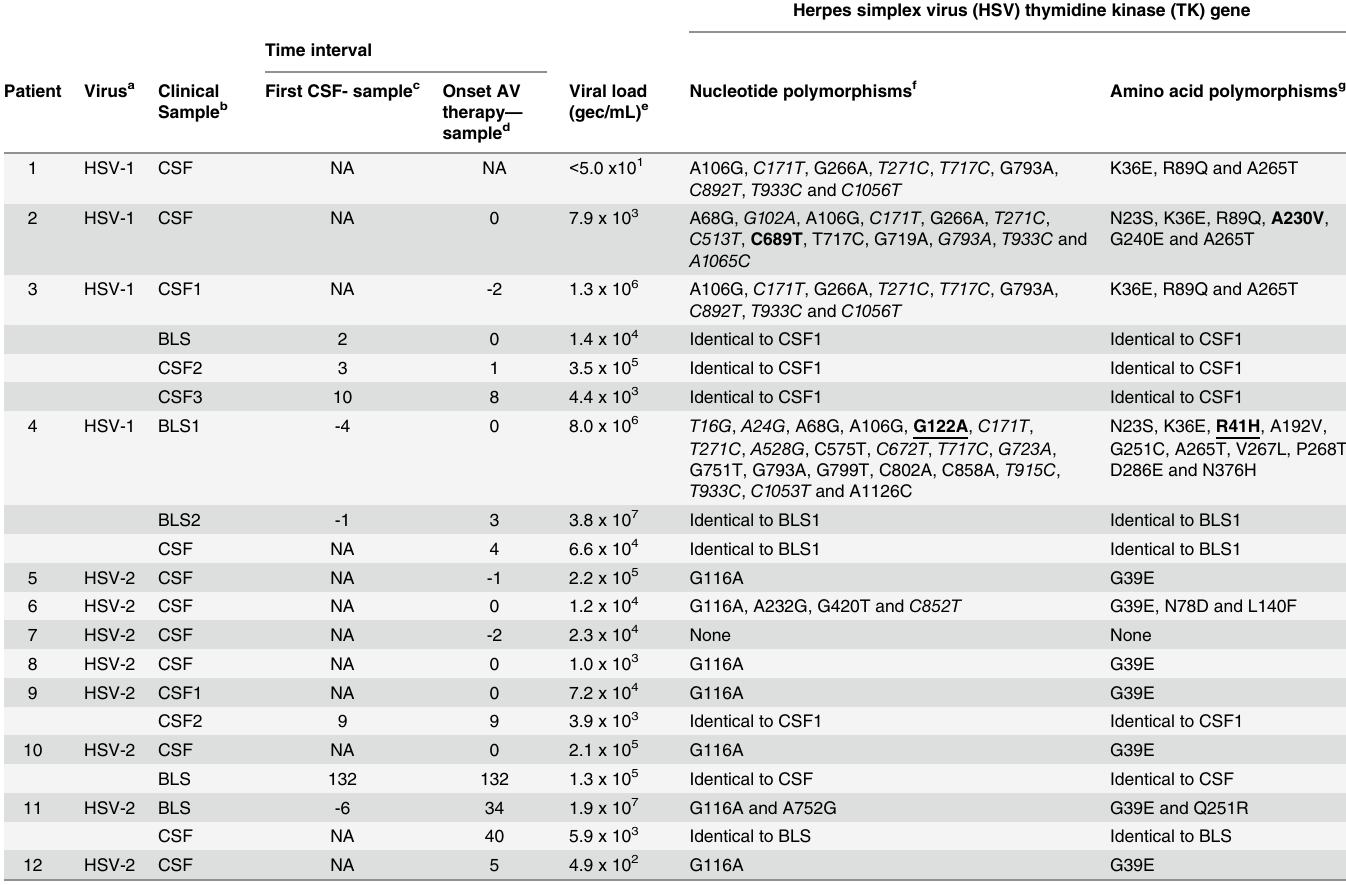
Herpes simplex virus (HSV) thymidine kinase (TK)